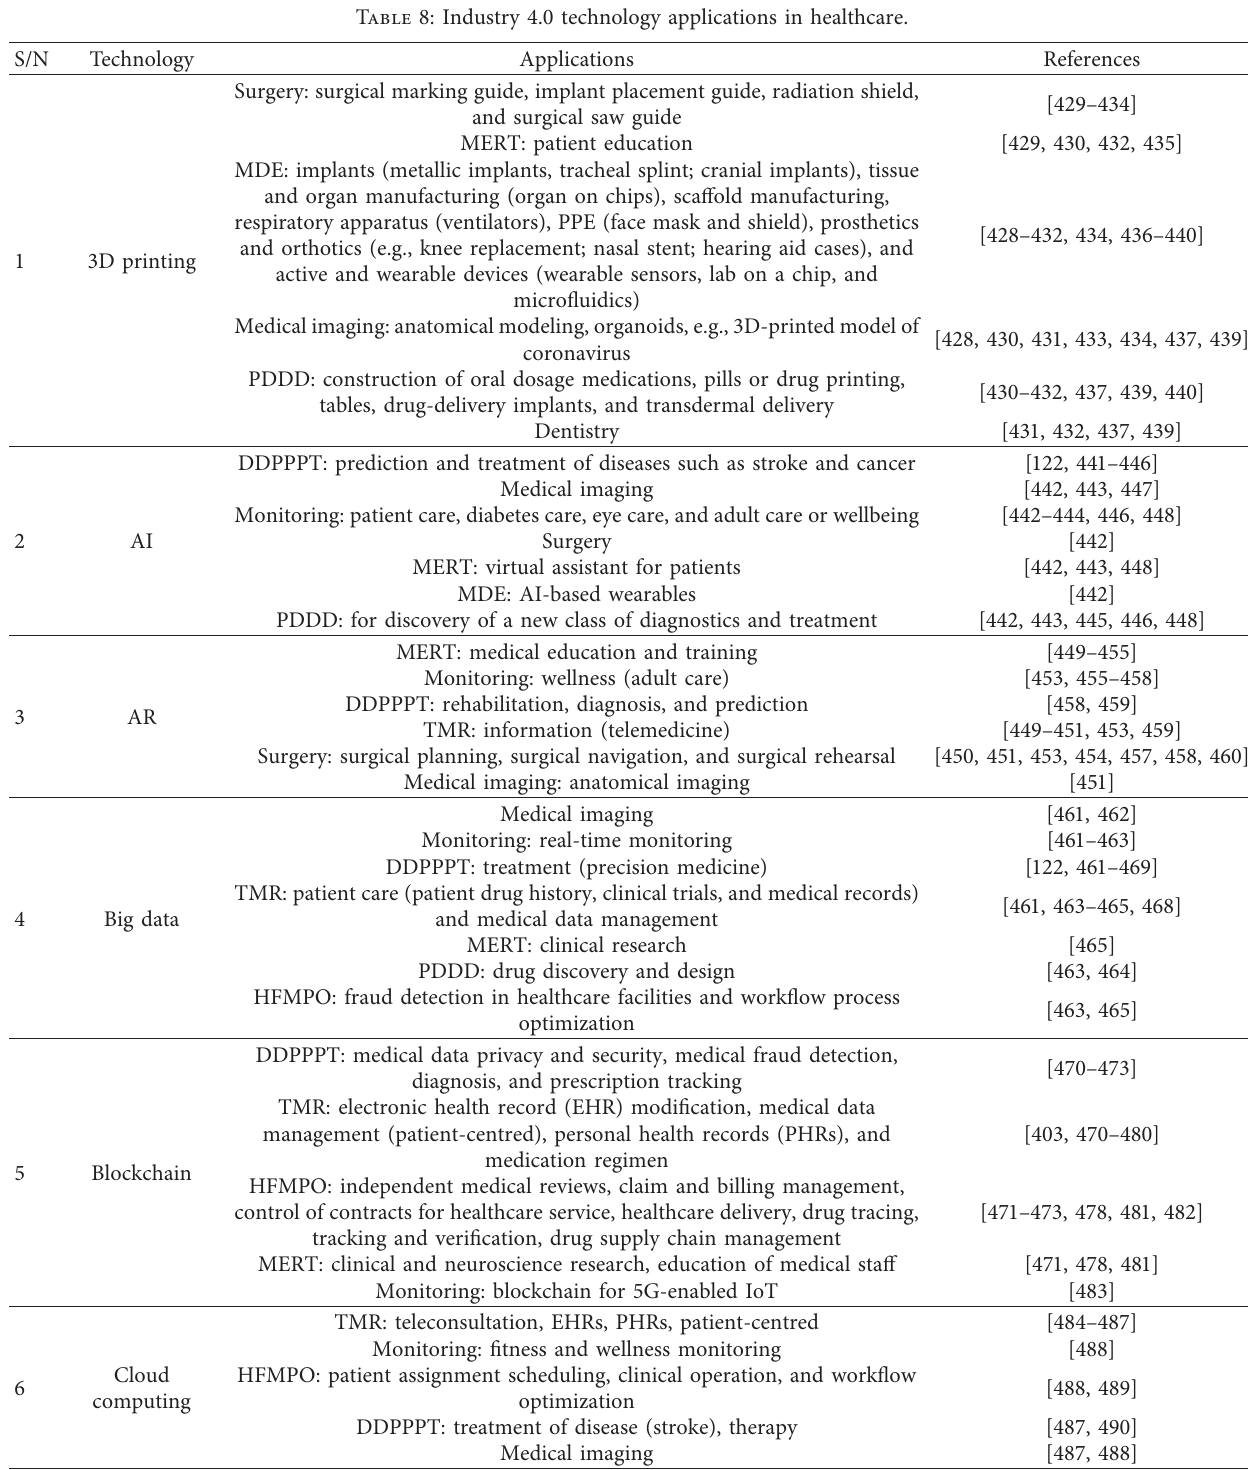
Table 8: Industry 4.0 technology applications in